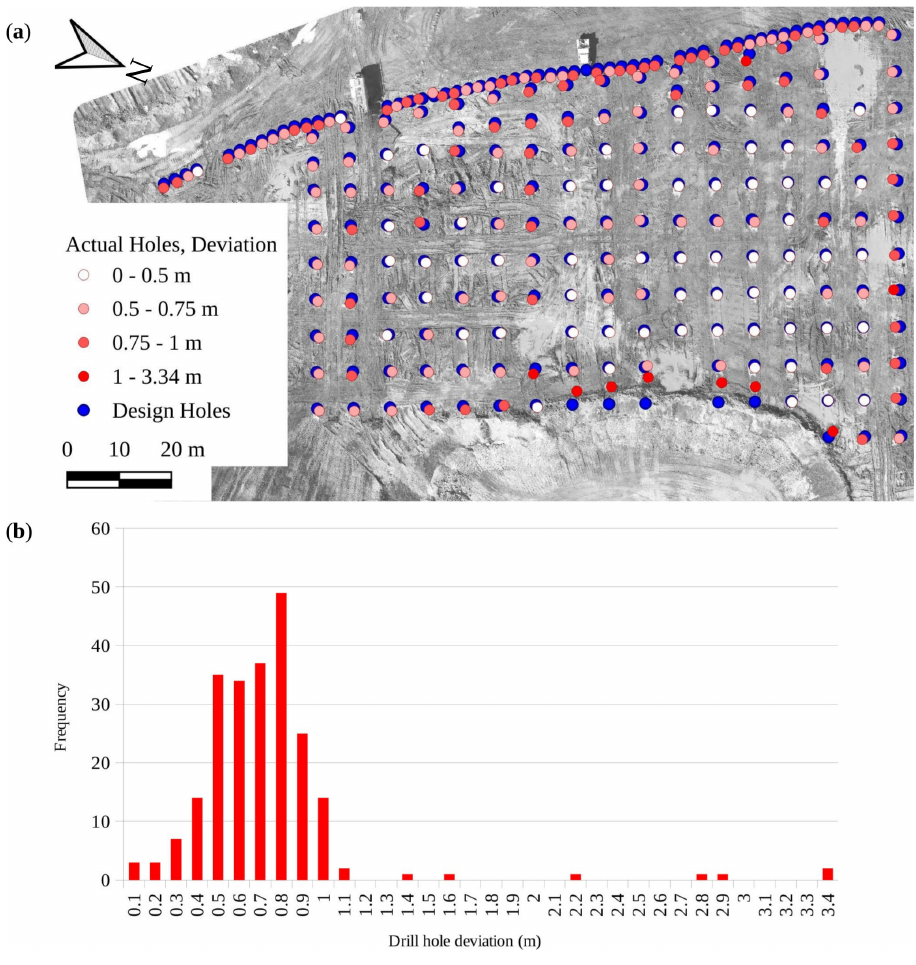
Figure 7. Blasthole deviation analysis for 230 holes with a diameter of 225 mm at the blast location in Mine D. ( a ) Orthomosaic with the designed (blue) and implemented (gradient red) blast pattern. ( b ) Histogram of visible drill hole collar deviation for the implemented blast